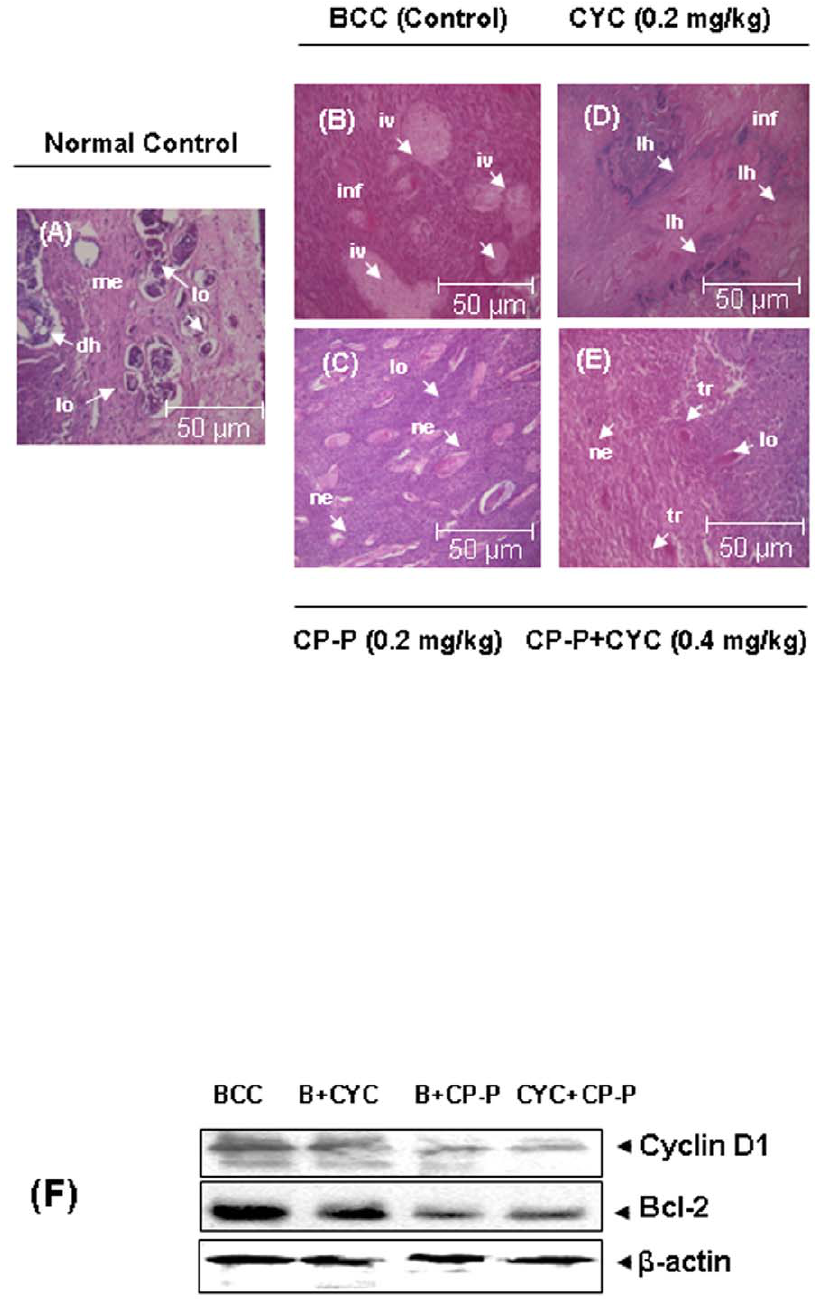
Figure 5. Histopathological examination of mammary tumor tissues. (A) Normal histology of breast tissue consisting lobules (l), myoepithelial (me), ductal hyperplasia (dh) with basement membrane. (B) Carcinoma of the rat mammary gland with extensive solid areas in small cluster. (C) Highly invasive (iv) tumor cells surrounding residual area and expanding into the adjacent stroma. Inhibitory potential of CP-P alone or in combination with CYC on DMBA-induced mammary tumors. (D) CYC inhibited the formation of lobular hyperplasia (lh) that is precursor to invasive disease. (E) The combination of CP-P + CYC treatment significantly reduced the number of inflammatory cells, hyperplasia and dysplasia respectively (Magnification 6 20). Symbol denotes: lo-lobules, me-myoepithelial, dh-ductal hyperplasia, iv-invasive solid areas, lh-lobular hyperplasia, ne- neovascularization. (F) CP-P inhibits expression of NF- k B-regulated gene products in breast cancer tissue samples. Western blot analysis showed the inhibition of the expression of Cyclin D1 and Bcl-2 by CP-P in whole cell extracts obtained from tumor tissues.